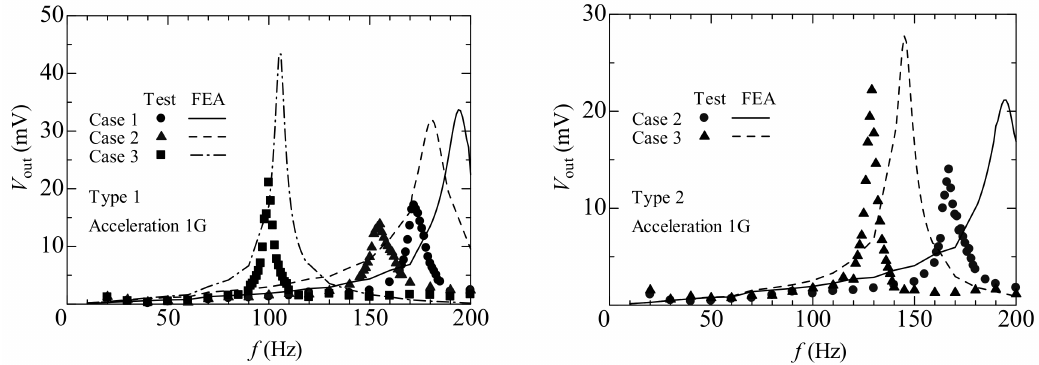
Figure 5. Output voltage versus frequency for the energy harvesting devices (Types 1 and